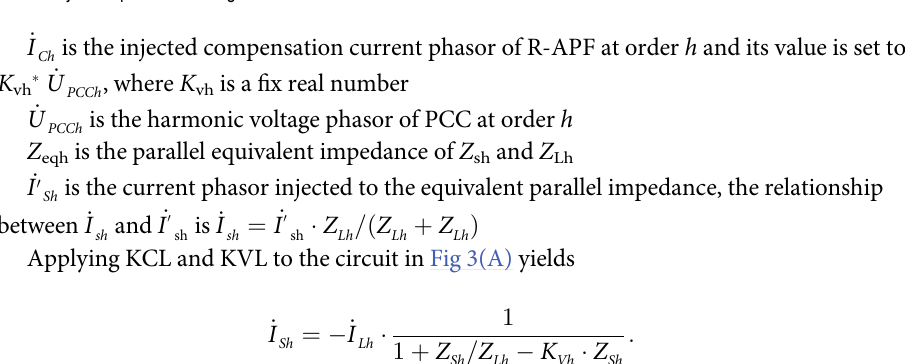
Fig 3. Principle circuit for R-APF: (a) per-phase equivalent circuit; (b) simplified.